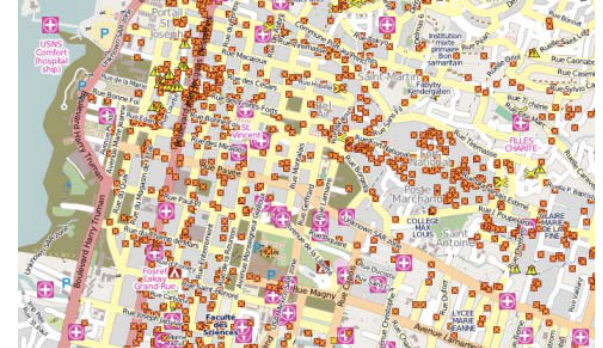
Figure 16: Part of the final OSM-Haiti earthquake damage map. 1.4M edits were performed during the first